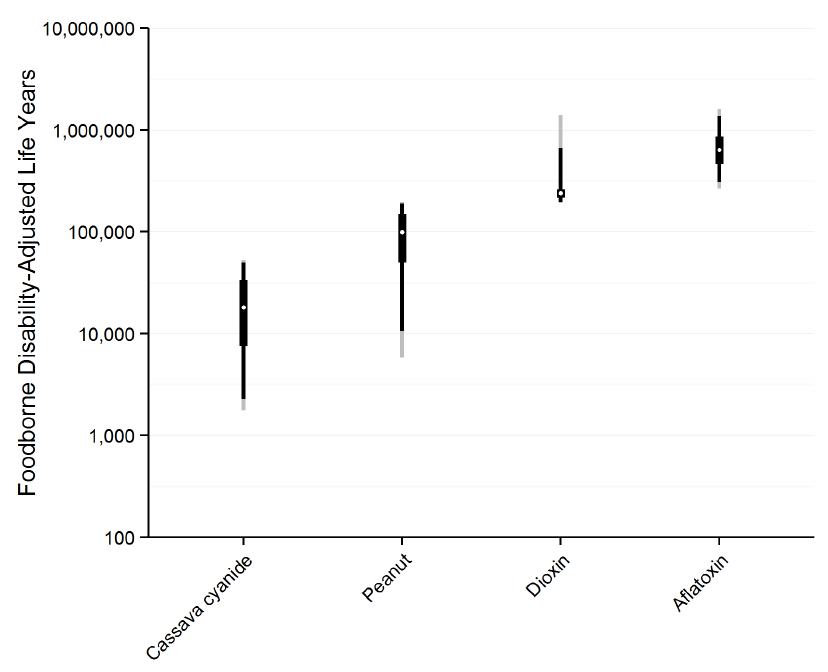
Figure 3. DALY for each of four chemicals from contaminated food ranked from lowest to highest with 95% UI (The dot in the middle of each box represents the median, the box the 50% UI, the dark bar the 95% UI, and the light bar the 95% UI).